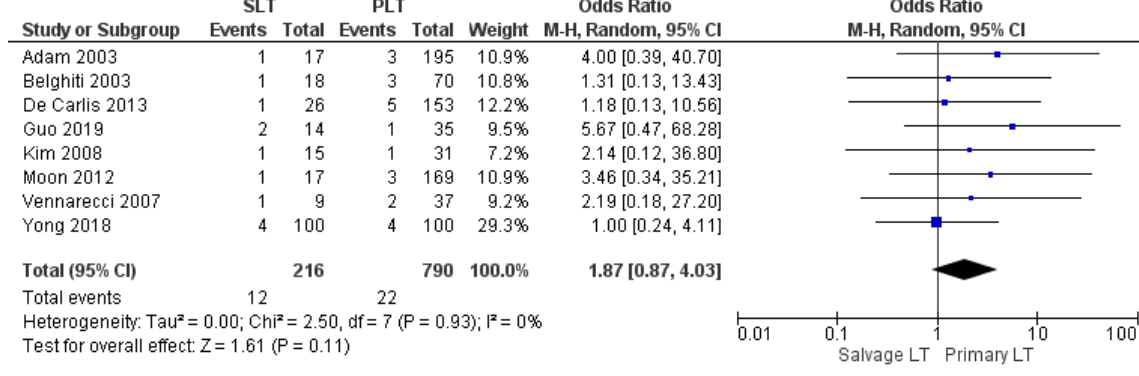
Figure 13. Arterial thrombosis.